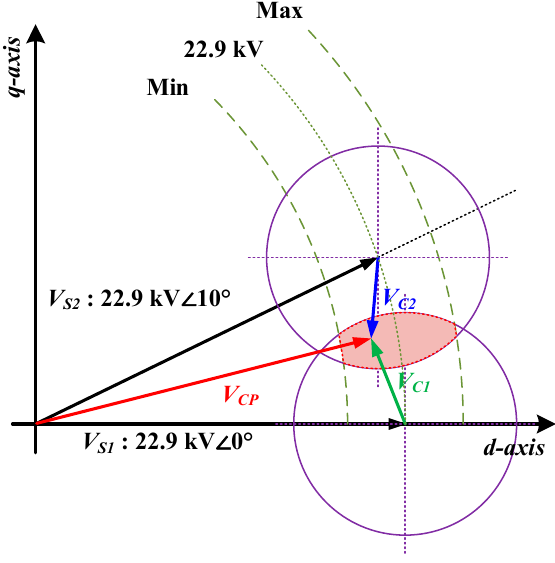
Figure 3. Vector diagram of the distribution line.